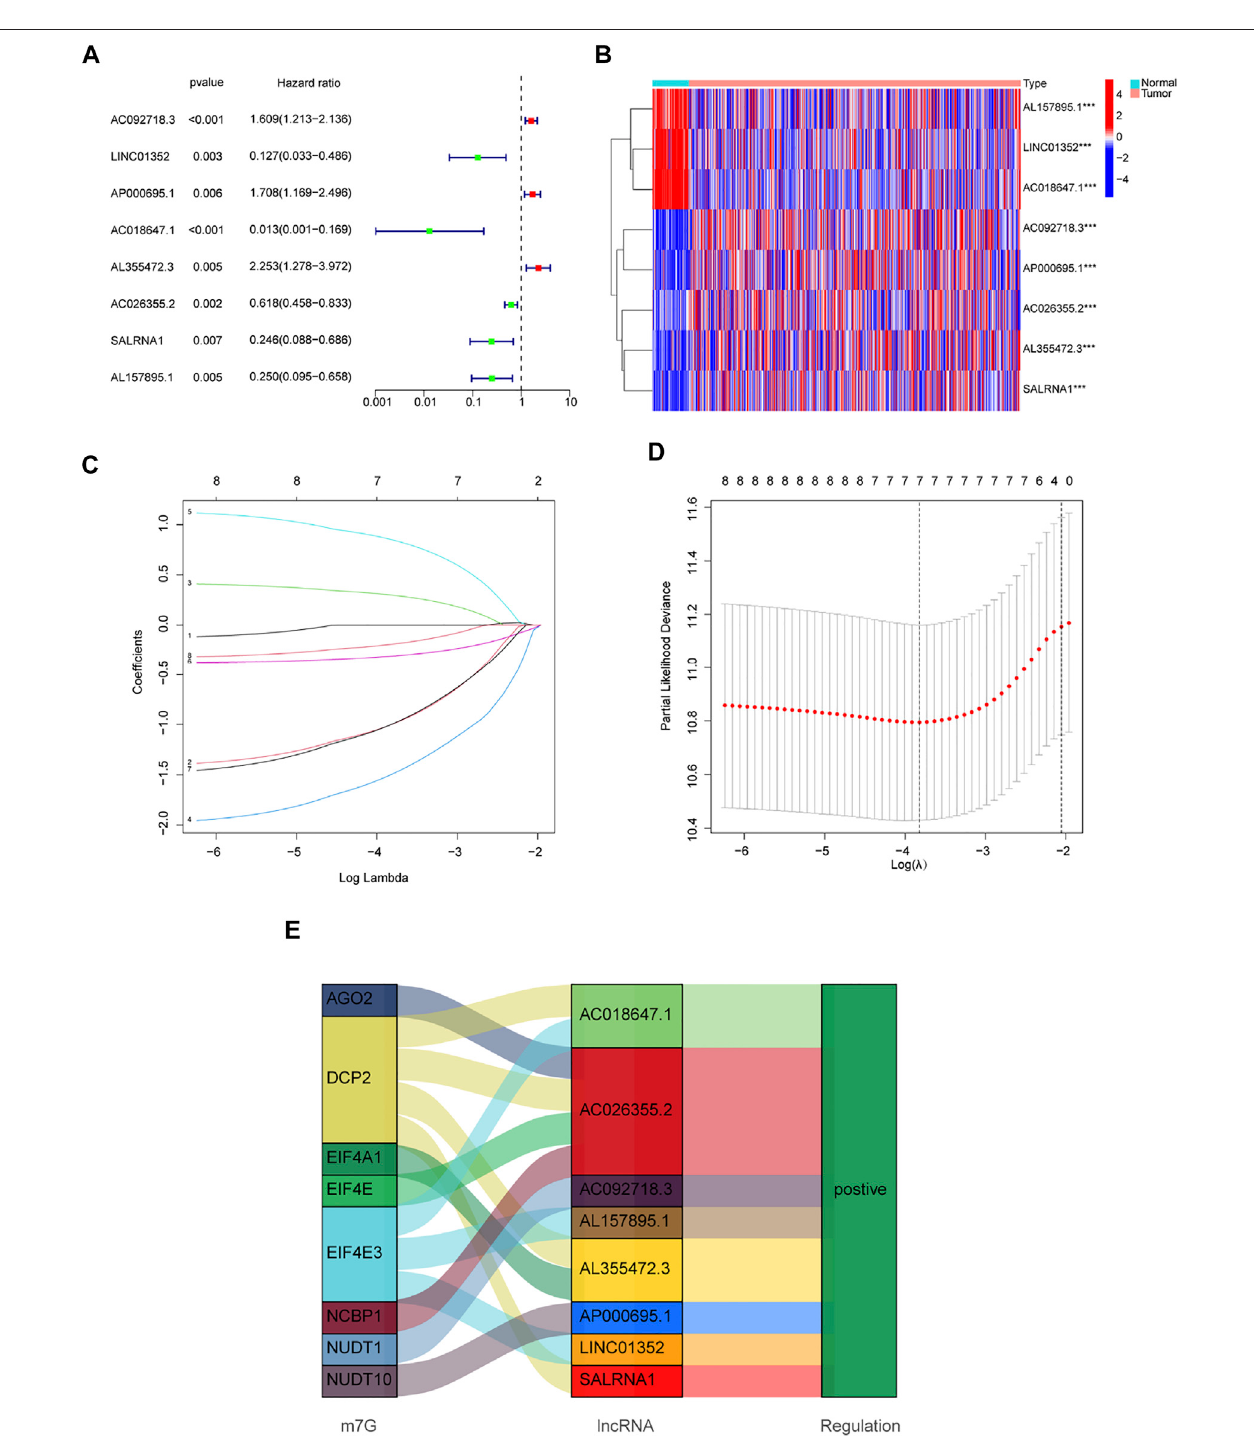
FIGURE 3 | Development of a new prognostic model for m7G-related lncRNAs in LUAD. (A) 8 prognosis-related lncRNAs screened by univariate Cox regression analysis ( p < 0.01). (B) Differential expression of prognosis-related lncRNAs in lung normal tissues and adenocarcinoma tissues. (C) LASSO coef fi cient distribution of 8m7G-related lncRNAs. (D) Thetuningparameter ( λ )intheLASSOmodelischosenbytheminimumcriterion. (E) TheSankeydiagramdepictsthedetailedconnections between eight prognosis-related lncRNAs and m7G-related genes. * p < 0.05, ** p < 0.01, *** p < 0.001.